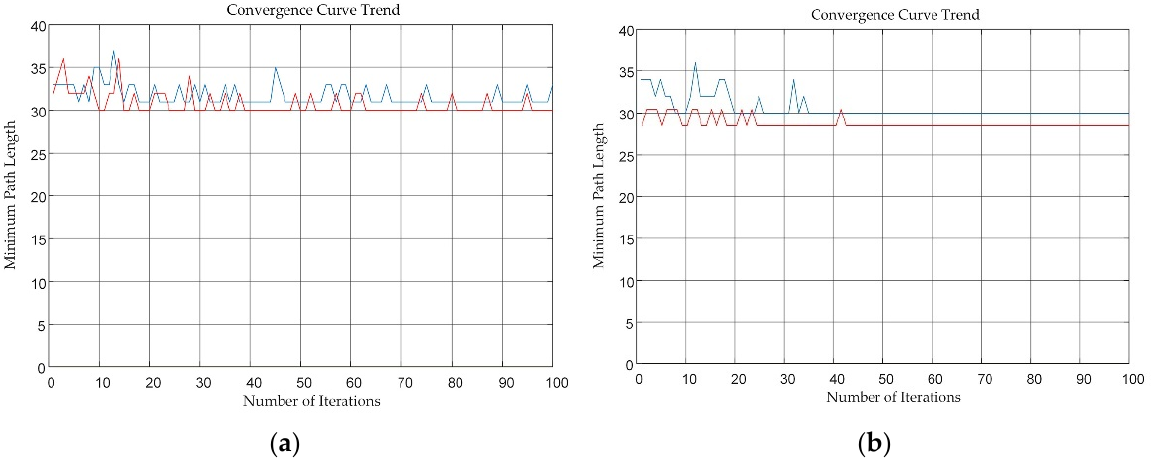
Figure 12. Schematic diagram of the convergence curve change of the ant colony algorithm (Environment 1). ( a ) Ant colony algorithm ( b ) Improved ant colony algorithm.